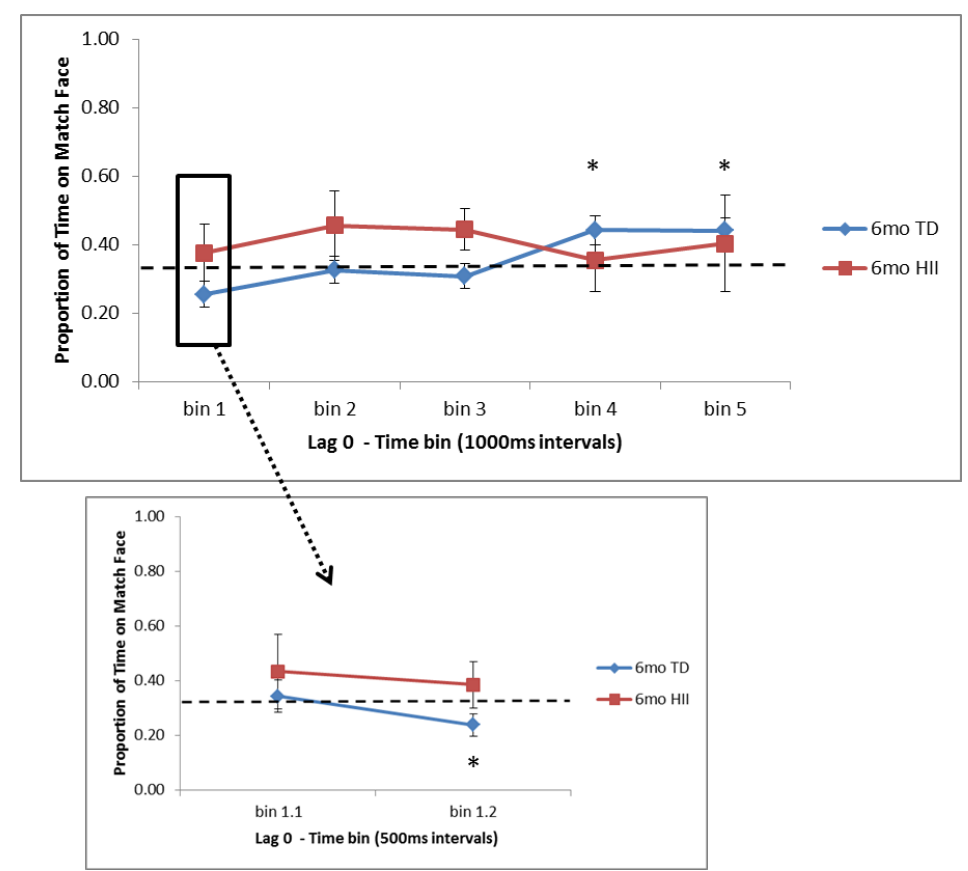
Figure 1. Proportion of time fixating the matching face for Lag 0 trials for the five 1000 ms time bins (bins 1–5) and the two 500 ms bins in the first 1000 ms (bins 1.1 and 1.2) for 6-month-old typically developing infants (TD) and hypoxic–ischemic injured infants (HII). Looking to the match face was significantly higher than expected by chance for 6-month TD infants in bins 4 (3000–4000 ms) and 5 (4000–5000 ms), and significantly lower than expected by chance in bin 1.2 (500–1000 ms). Chance is illustrated with a dashed line; error bars indicate the standard error of the mean. * p < 0.05 Table 3. Percentage of time on match face in TD and HII at 6 and 12 months during the full time window (0–5000 ms) for relational memory.